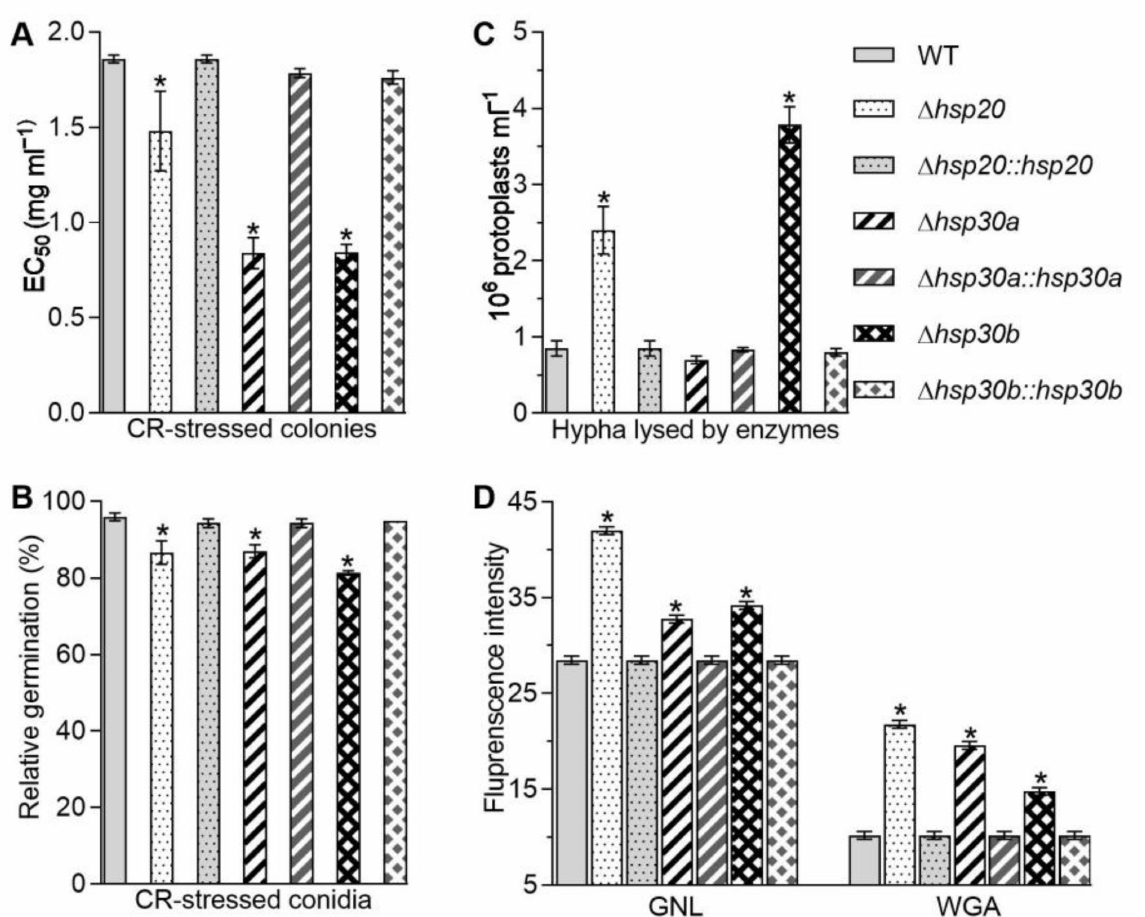
Figure 3. Contributions of hsp20 , hsp30a , and hsp30b to cell wall integrity of B. bassiana . ( A ) EC 50 for Congo red to suppress 50% colony growth of each strain after 6 d incubation at 25 ◦ C on 1/4 SDAY plates. ( B ) Relative germination percentages of conidia on the GM plate alone and supplemented with Congo red (1 mg/mL) after 24 h incubation at 25 ◦ C. ( C ) Concentrations of protoplasts released from the hyphal cells after 6 h treatment with cell wall lysing enzymes in osmotic solution of 0.8 M sucrose. ( D ) Fluorescence intensity from flow cytometry of 2 × 10 4 conidia labeled with the fluorescent lectins GNL and WGA. Asterisked bars in each bar group differ significantly from those unmarked (Tukey’s HSD, p < 0.05). Error bar: SD from three